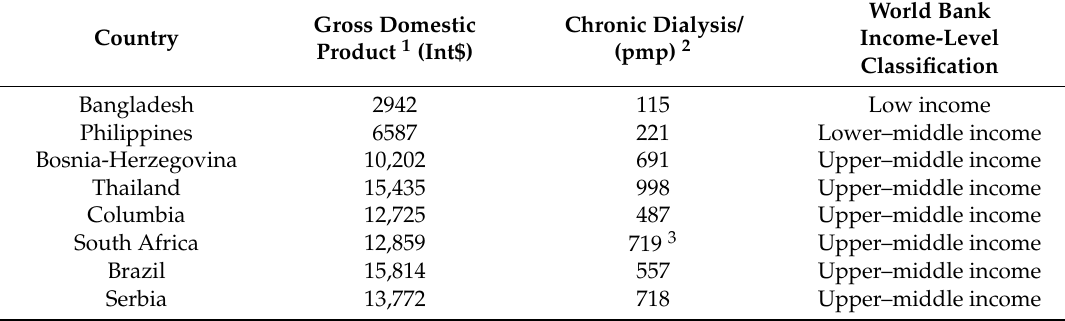
Table 1. Prevalence of chronic dialysis across some upper–middle income countries. World Bank Gross Domestic Chronic Dialysis/ Income-Level Country Product 1 (Int$) (pmp) 2 Classification Bangladesh 2942 115 Low